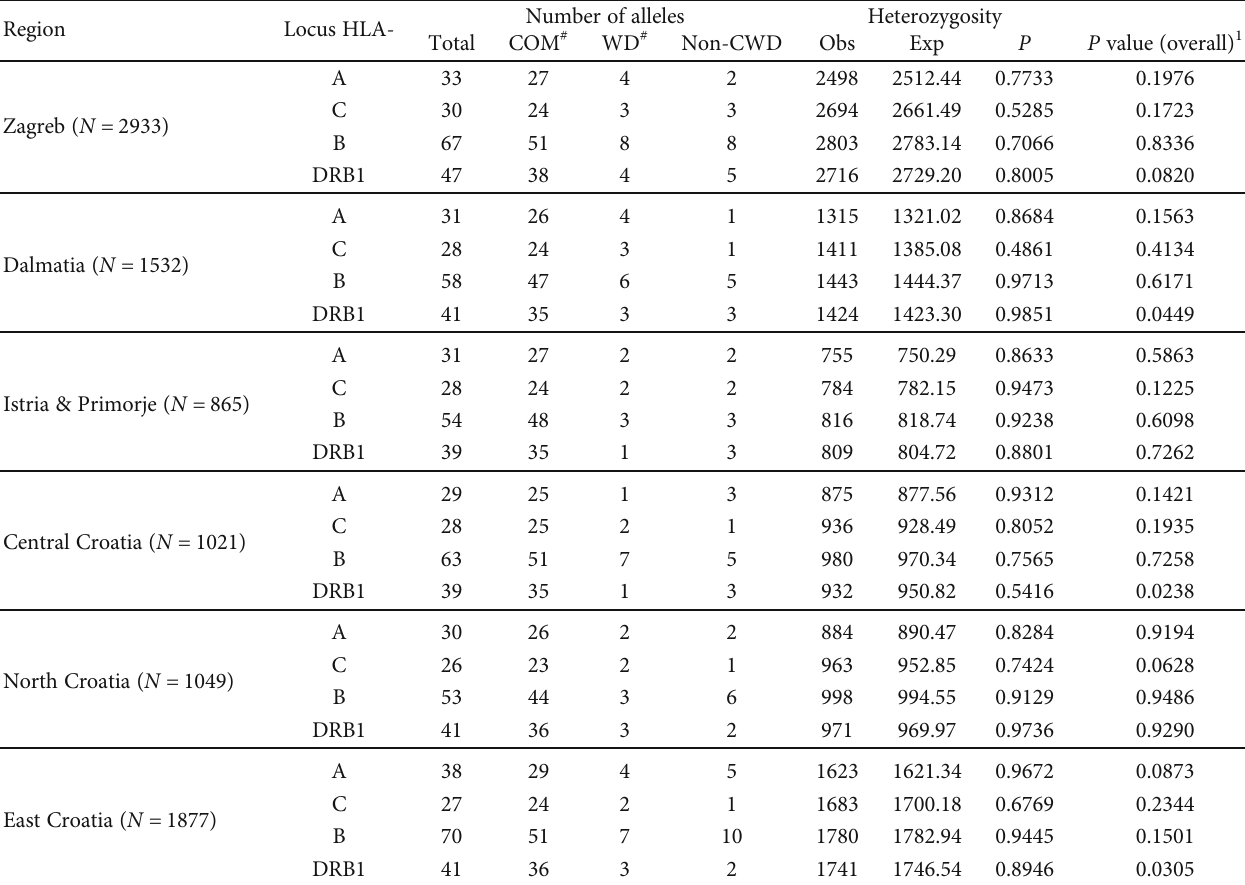
Table 1: Polymorphism at HLA-A, -C, -B, and -DRB1 loci in the Croatian population ( N = 9277 ): heterozygosity parameters and categorization according to the EFI CWD catalogue 18